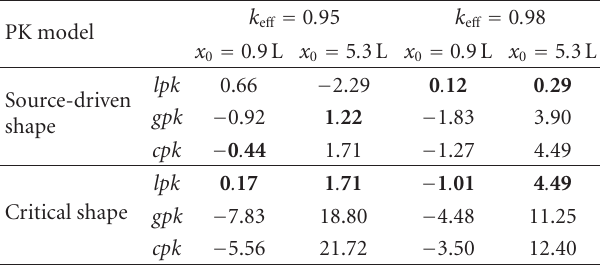
Table 1: Percentage relative error on the integral of the flux in the detector positions, as obtained by the di ff erent point kinetic models with respect to the reference solution. In bold the “best” results are